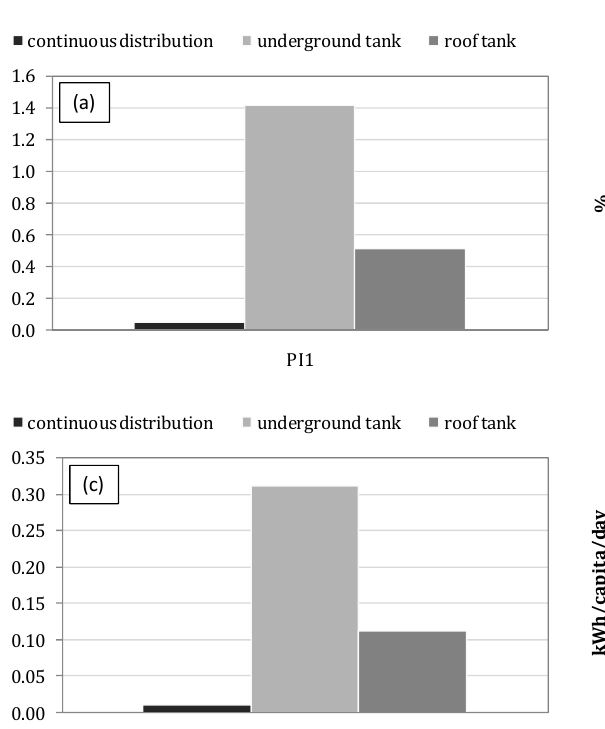
Figure 8. Comparison between the PIs value assessed for the entire network in the three scenarios: ( a ) PI1, ( b ) PI2, (c) PI3 and ( d )